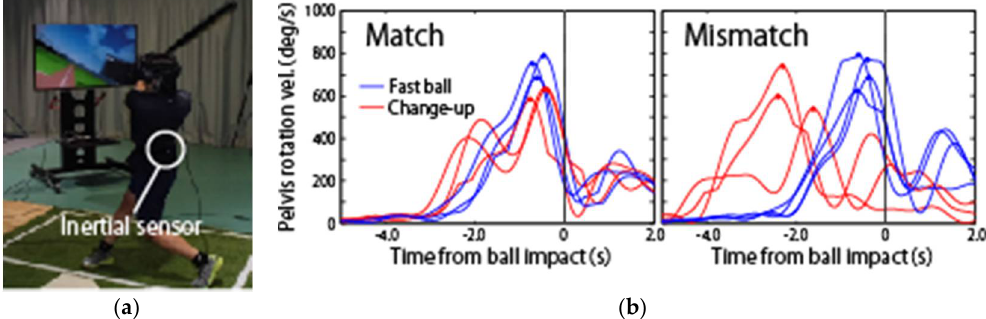
Figure 3. ( a ) Experimental scenery; ( b ) Examples of the pelvis rotation velocity profiles aligned at the ball impact in a single participant. Each dot shows the detected peak of rotation velocity in each